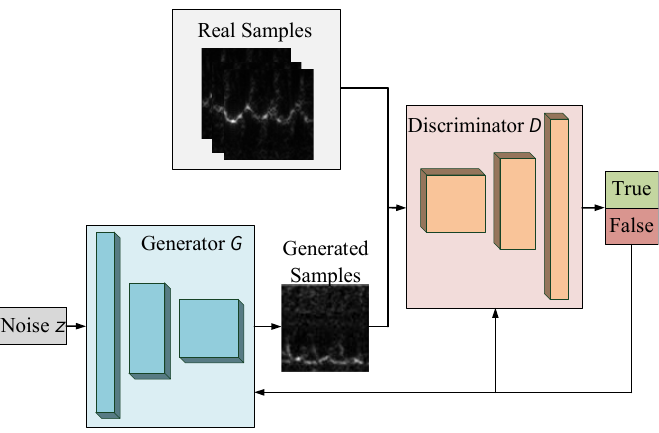
Figure 1. The GAN architecture.